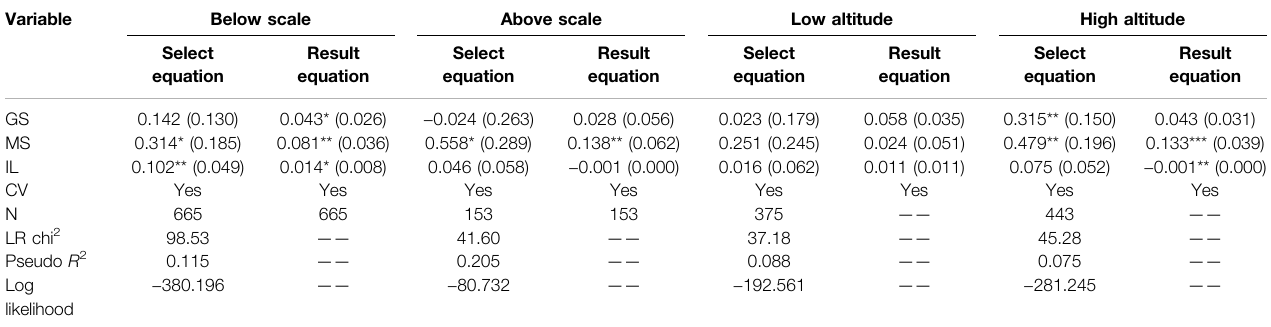
TABLE 6 | Heterogeneity